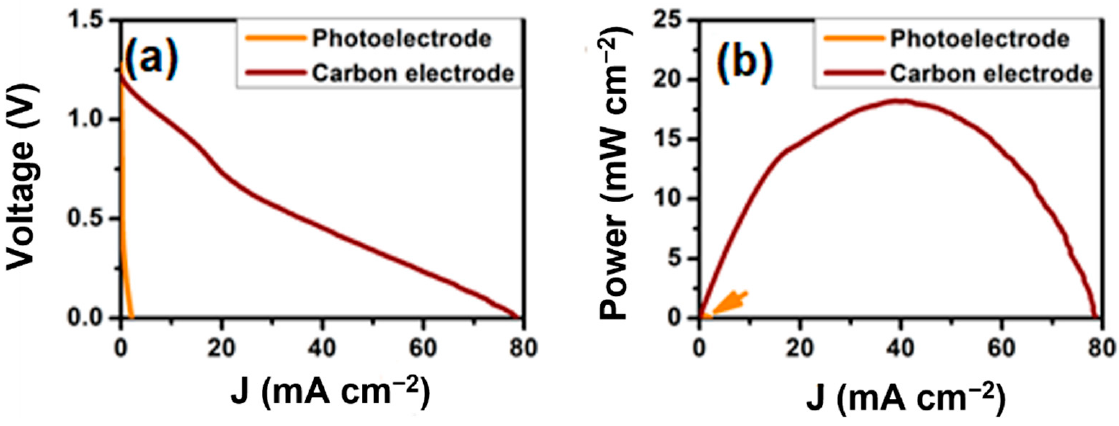
Figure 9. J × V ( a ) and J × P curves ( b ) for the zinc-air battery discharging using either a Nb 2 O 5 -CdS photoelectrode or a typical carbon electrode as the air electrode.